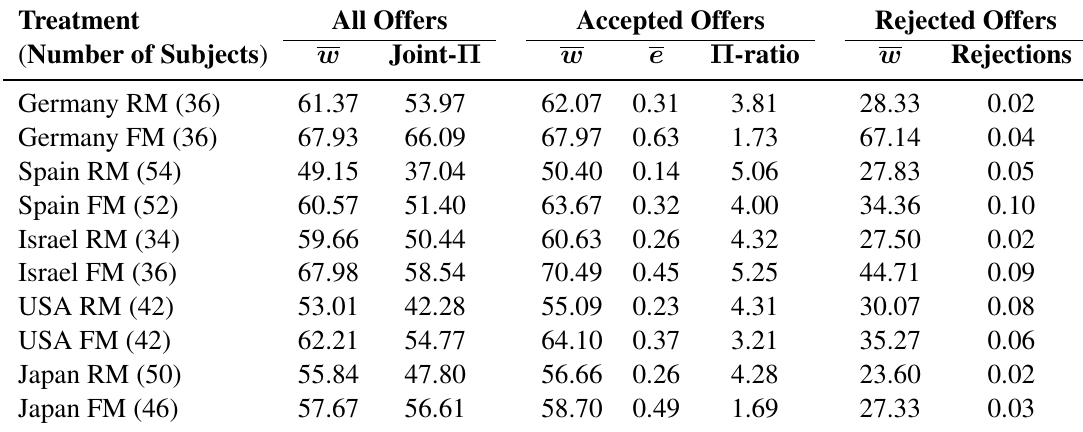
Table 2. Average outcomes in the different treatments (Rounds 2–9). RM, random matching; FM, fixed